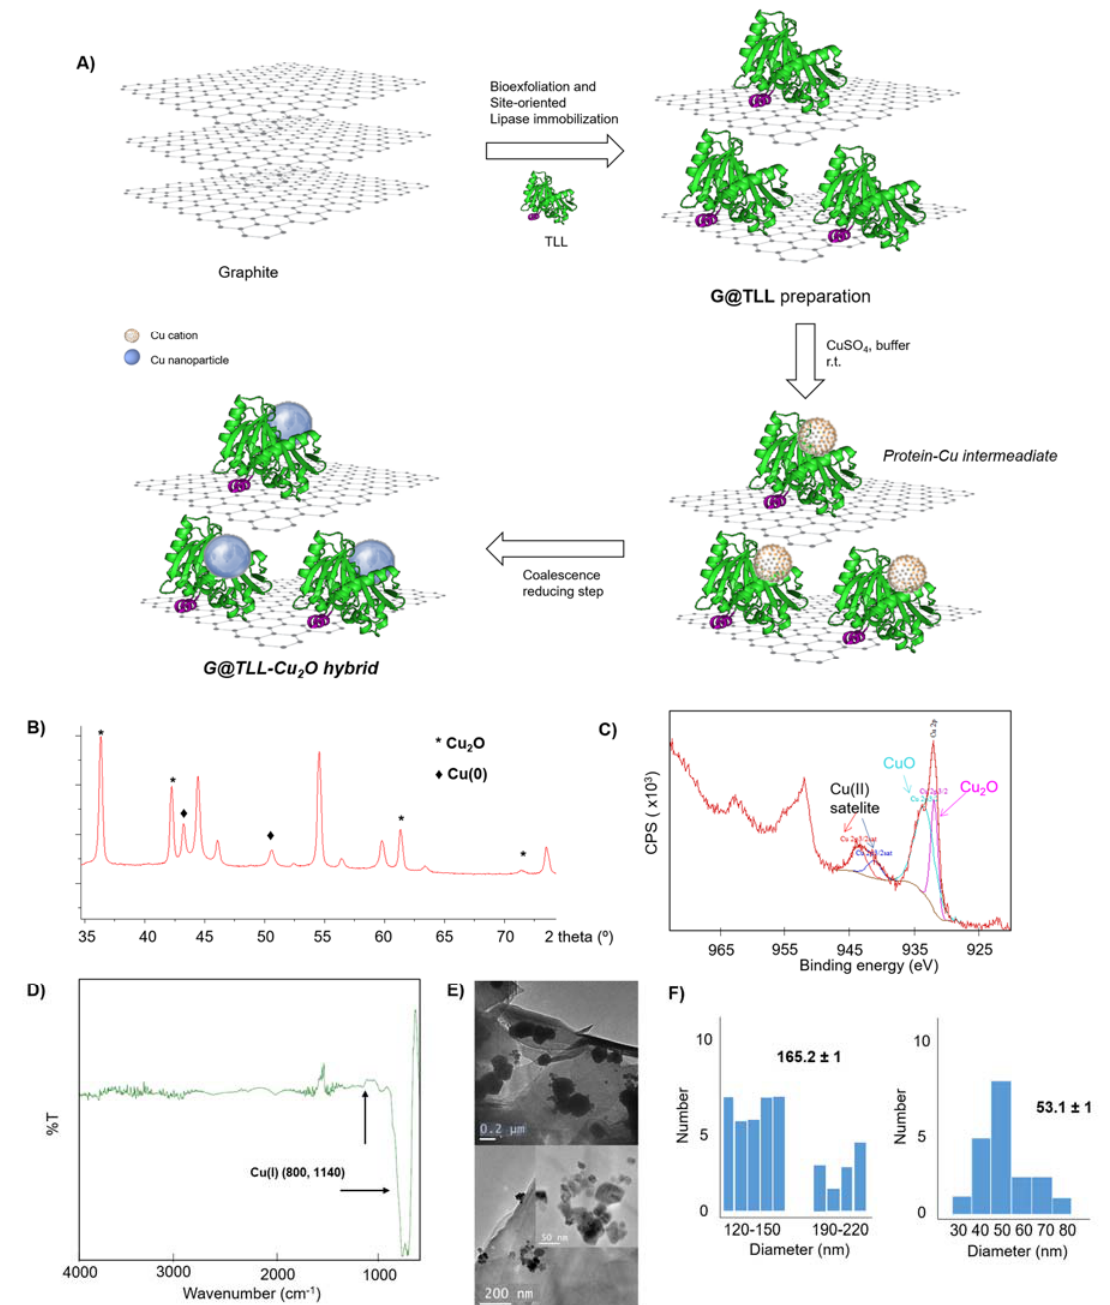
Figure 1. ( A ) G@TLL ‐ Cu 2 O hybrid preparation scheme; ( B ) XRD spectrum; ( C ) XPS spectrum of Cu2p; ( D ) FT ‐ IR spectrum; ( E ) TEM images and HR ‐ TEM image (inset); ( F ) Nanoparticles size dis ‐